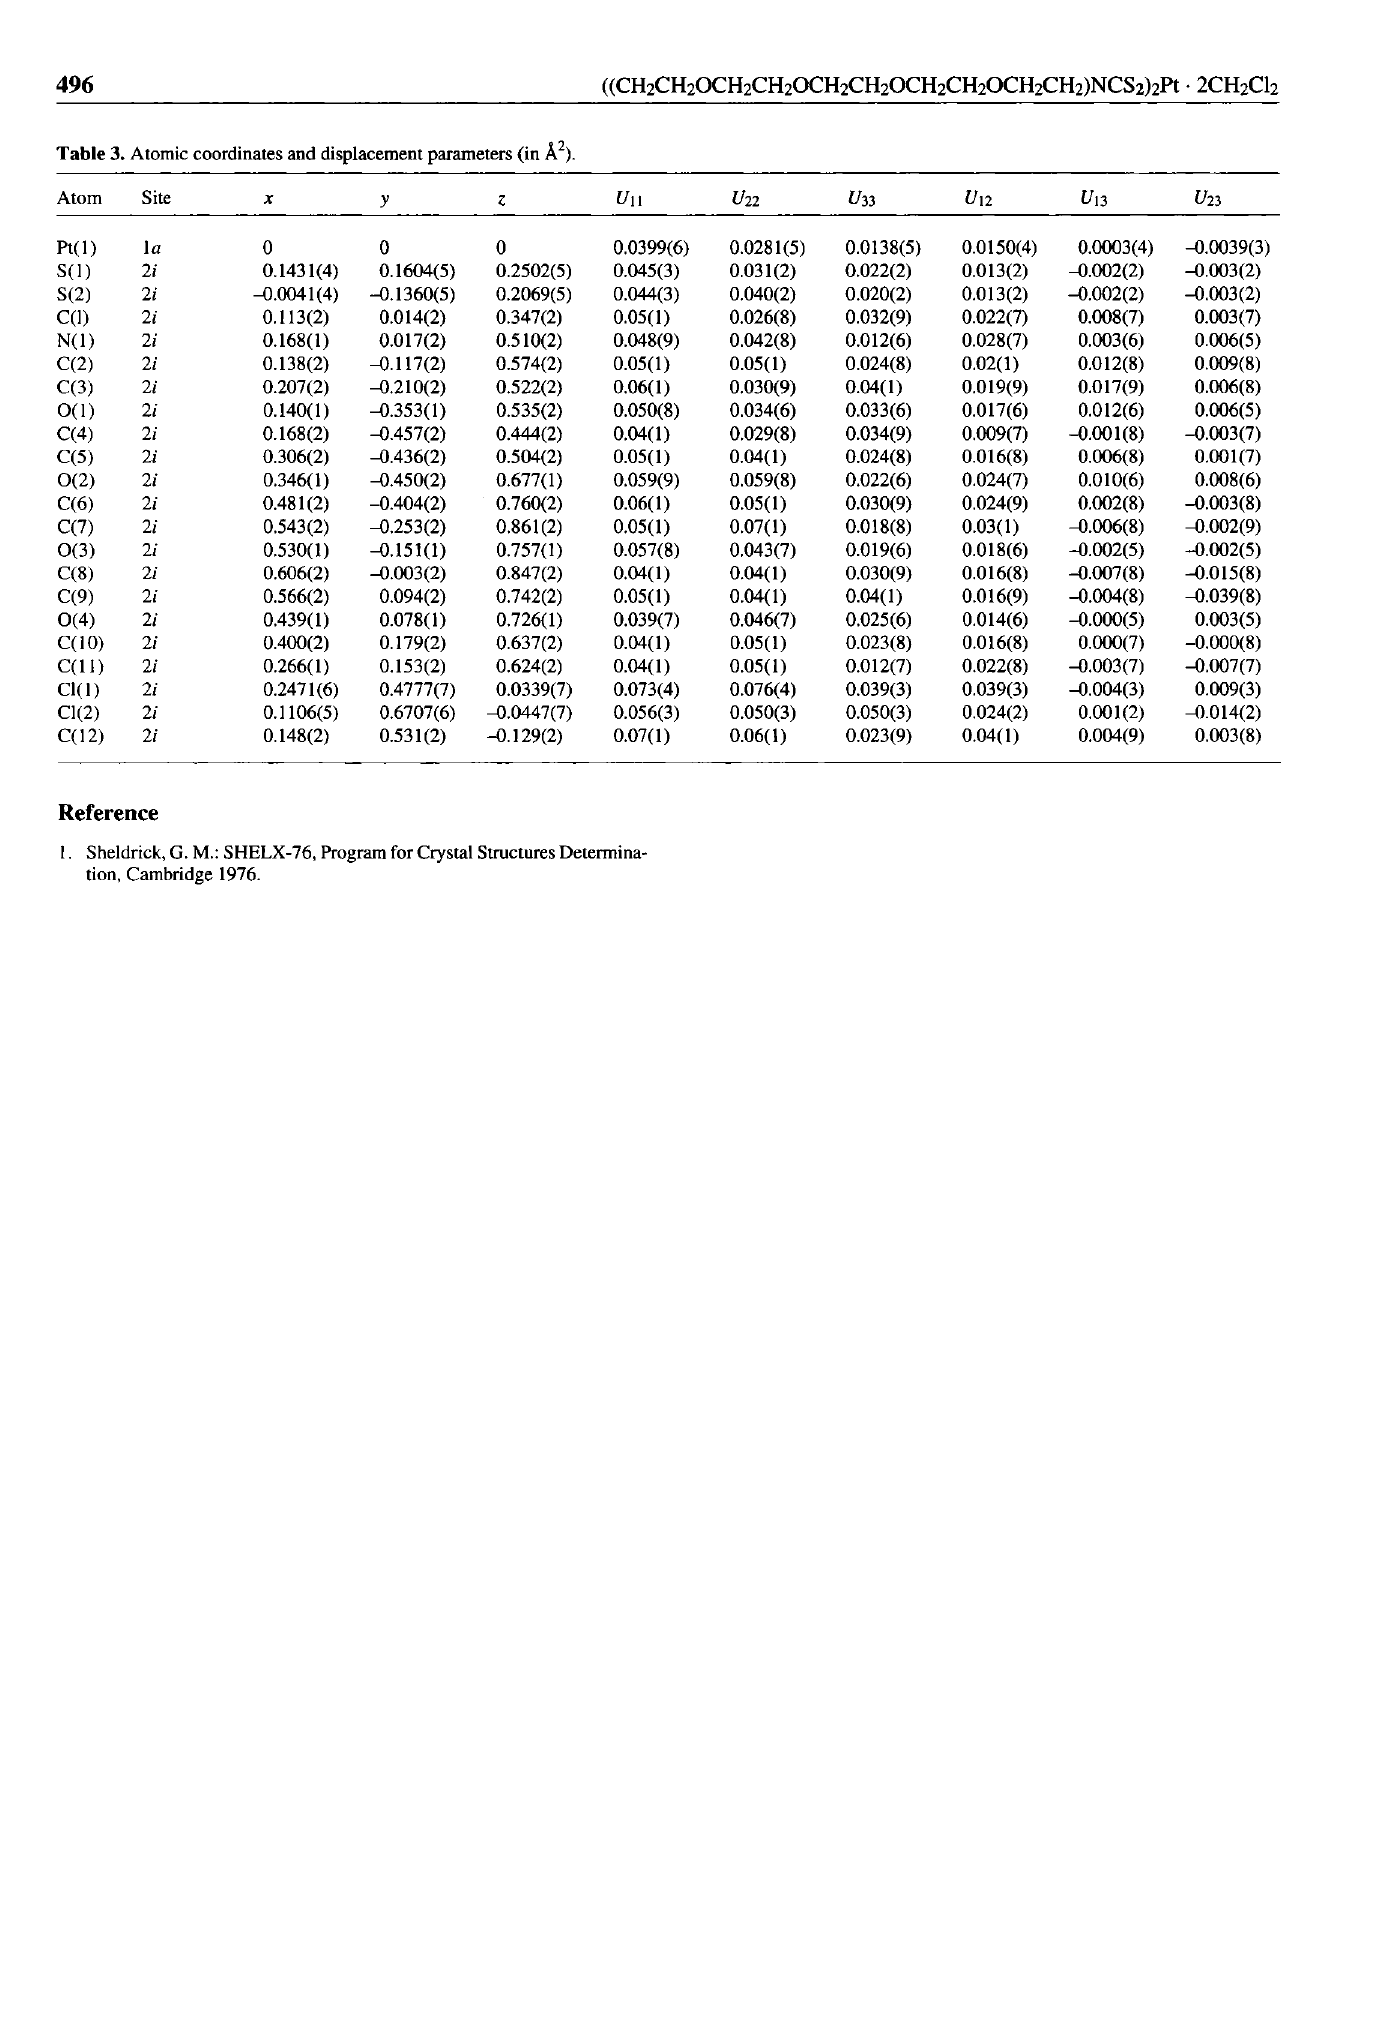
Table 3. Atomic coordinates and displacement parameters (in Ä 2